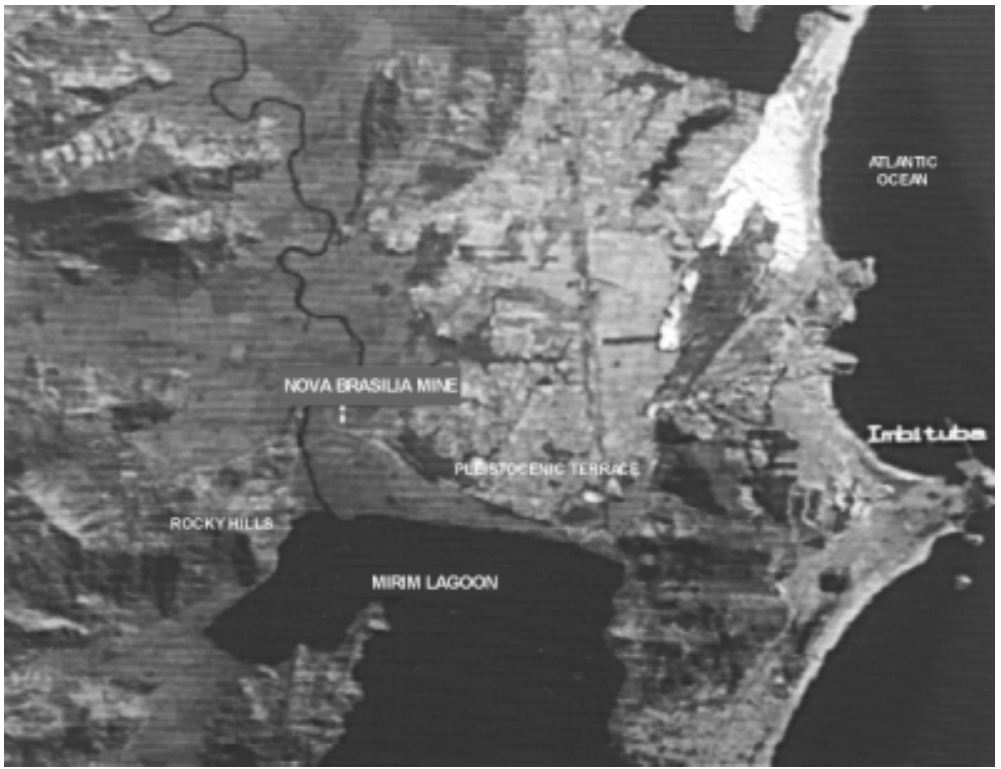
Fig. 10 – Geographic situation of the Nova Brasília calcareous shell